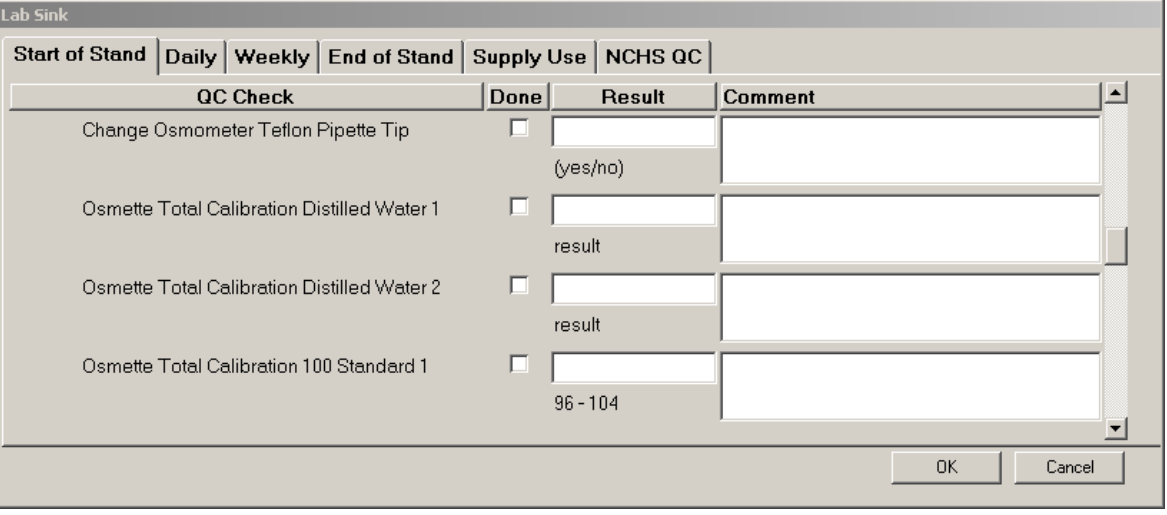
to the beginning of the Osmette Start of Stand QC